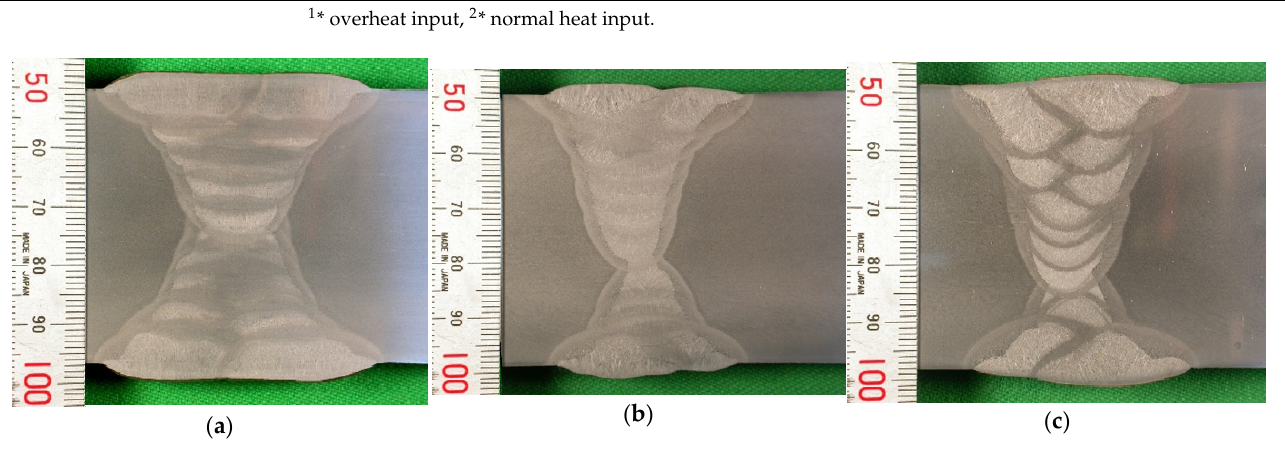
Table 2. Welding parameters used for welding The main weld parameters used for FCAW, overheat input conditions are: (1) aver-